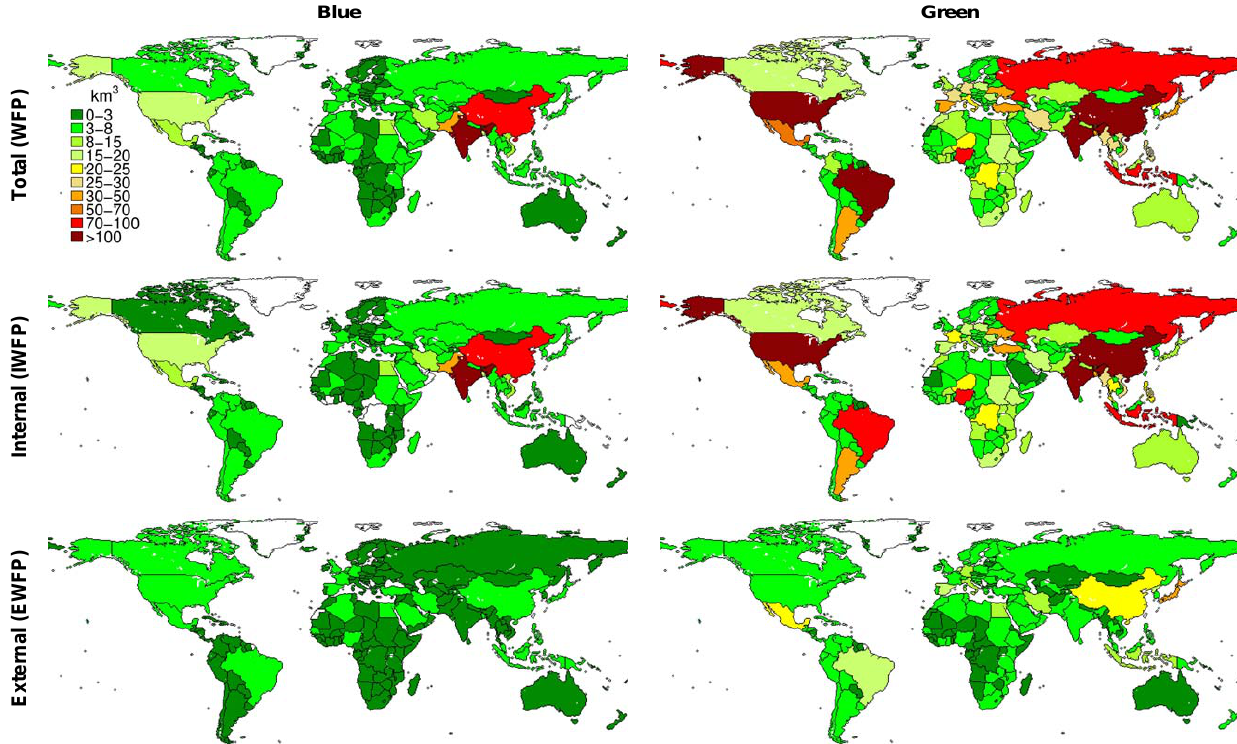
Fig. 4 . Fig. 4. Internal, external and total blue and green water footprints per country for all CFTs, 1998–2002